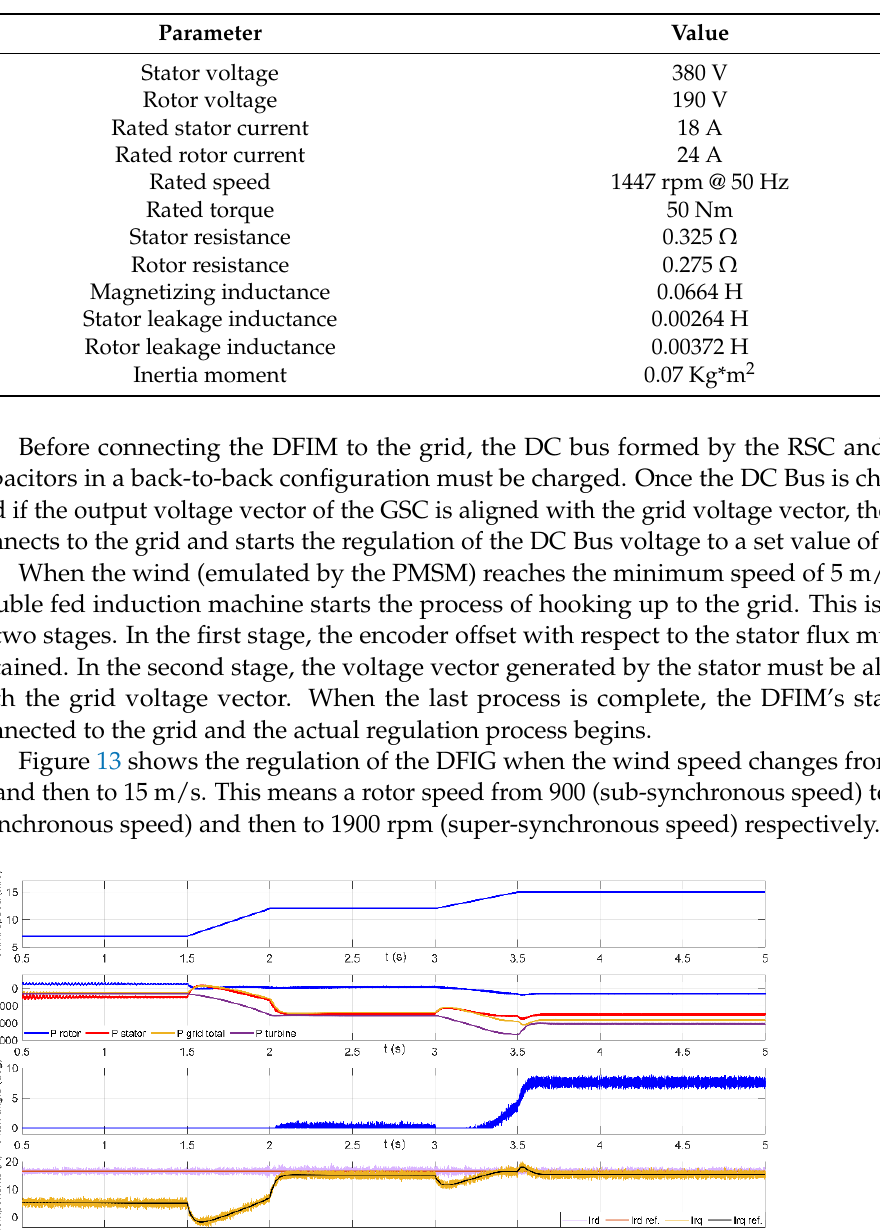
Table 1. Leroy Somer DFIM main parameters